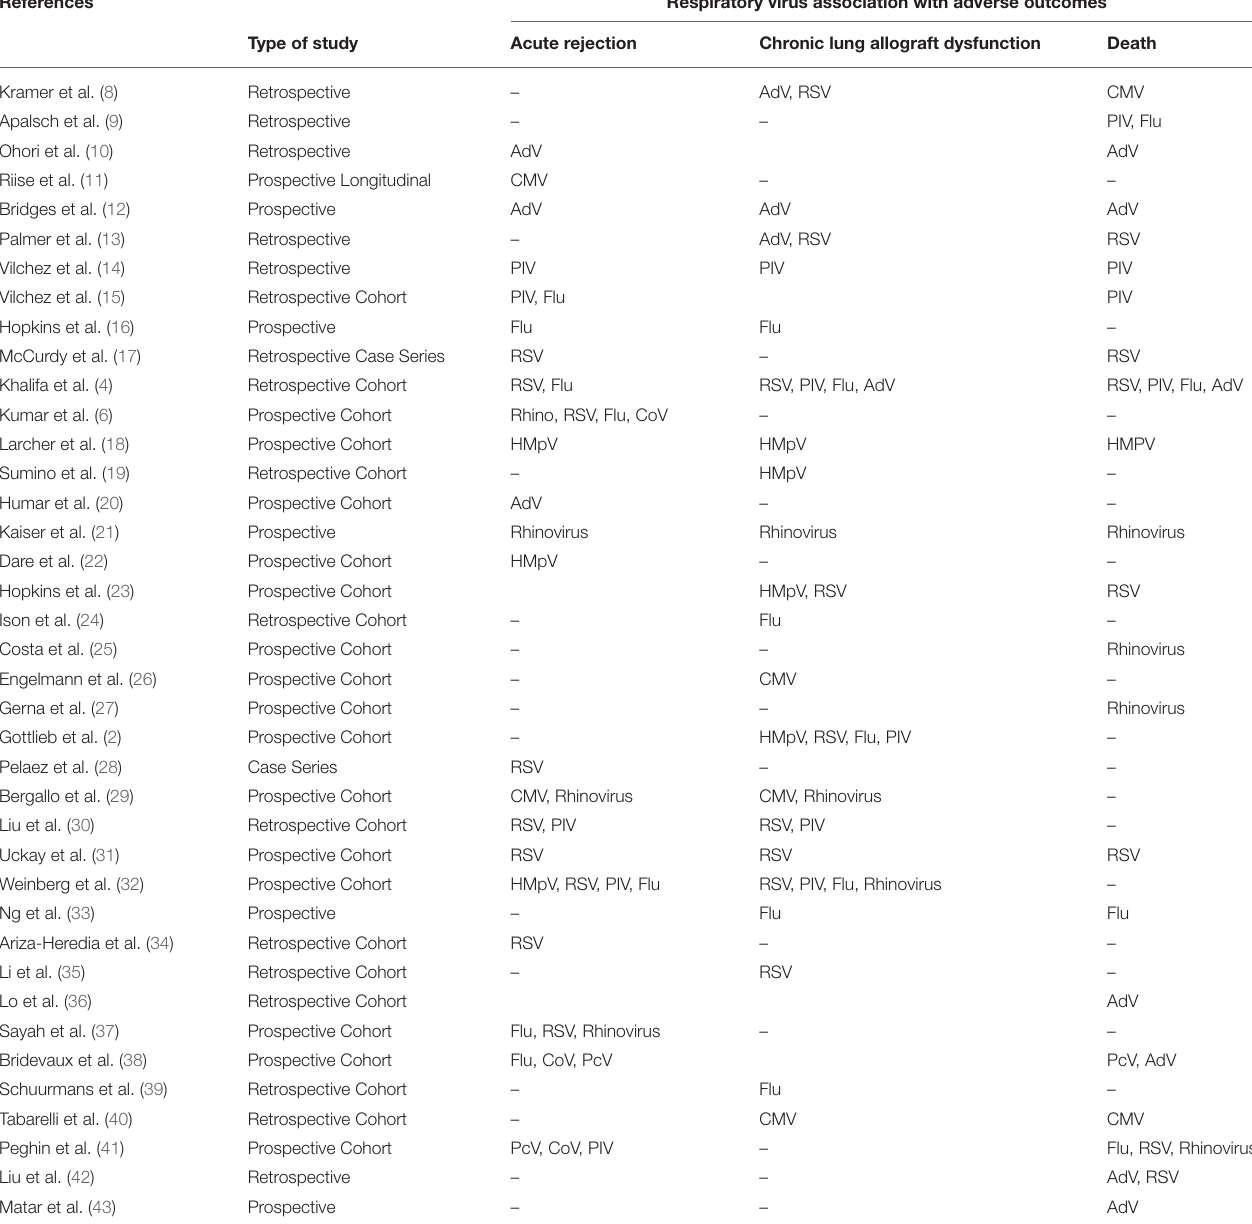
TABLE 1 | Publications reporting virus association between lung transplant and adverse